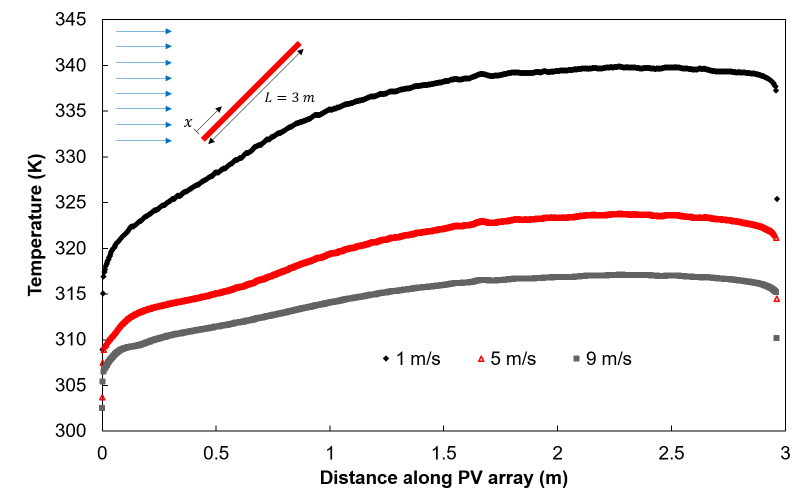
Figure 14. Temperature along the length of PV array at different wind